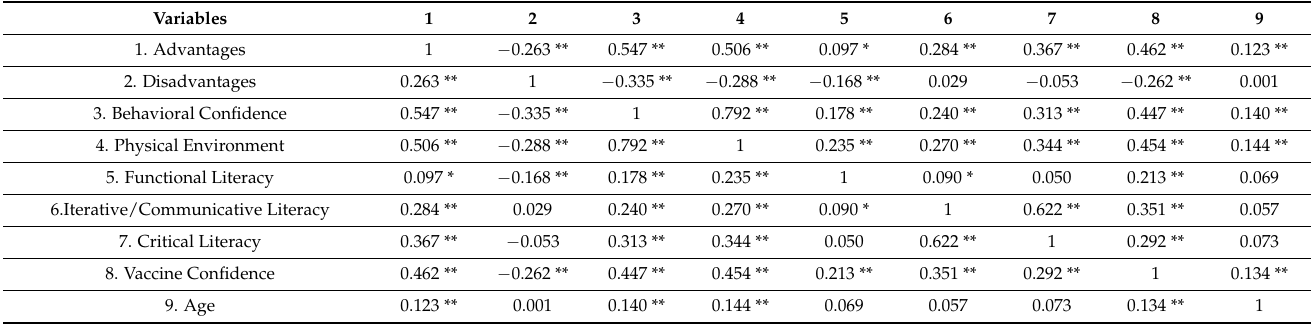
Table 4. Pearson correlations for study variables in the sample population ( n = 687).